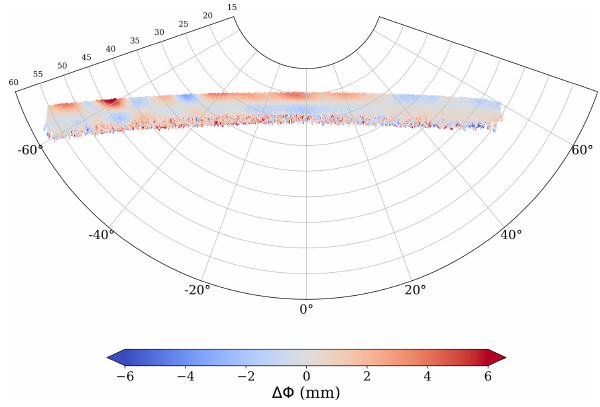
Figure 6. Antenna pattern for the (cid:49)(cid:56) m as a function of azimuth ( x axis) and elevation ( y axis) in the antenna reference frame ( ϕ A , θ A ).